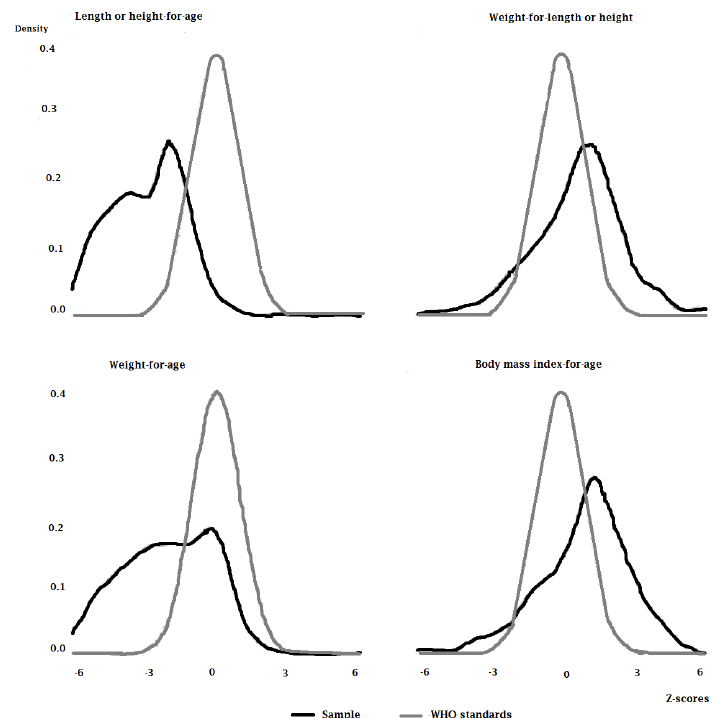
Figure 1. Z − Scores distribution of sample.